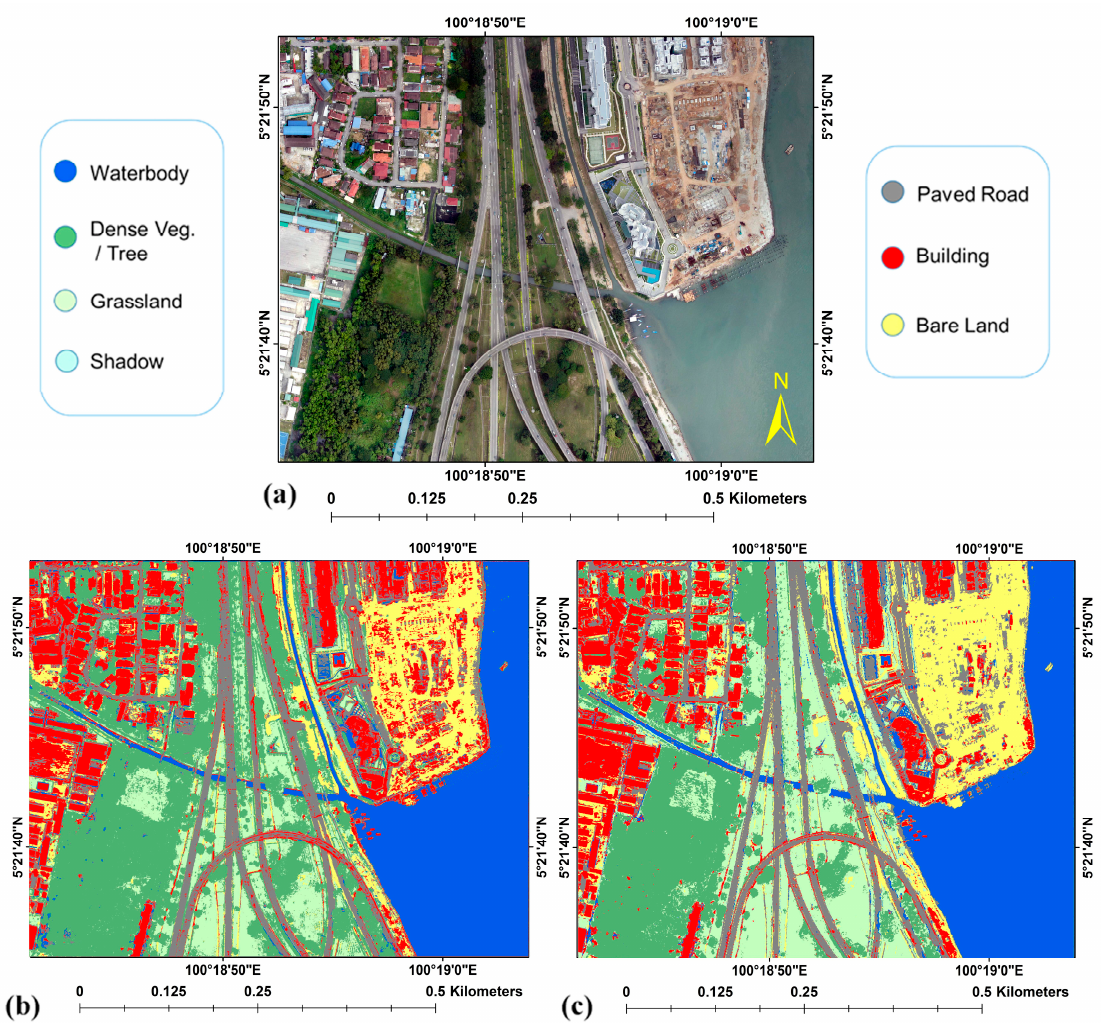
Figure 7. Classification map produced by the CNN based on the two datasets: ( a ) GT, ( b ) RGB only dataset and ( c ) the RGB + DSM dataset. Table 6. Performance of the classification methods used in the current study measured using standard accuracy metrics.